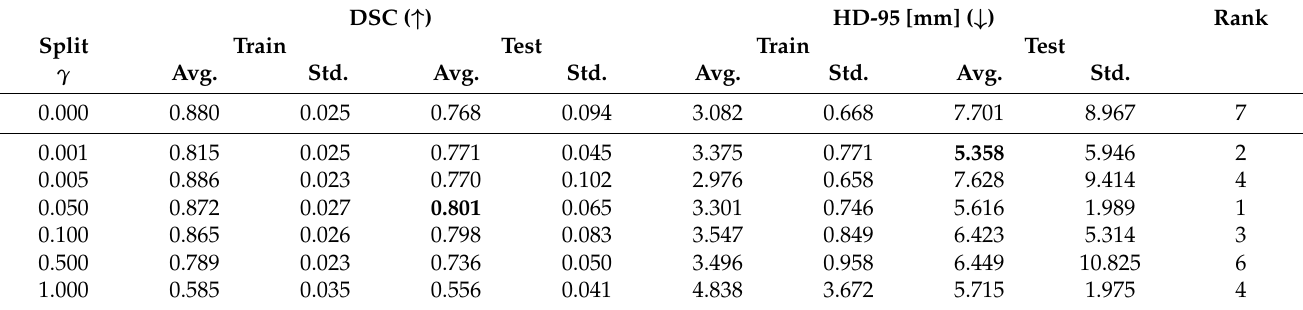
Table 4. Performance metrics for the shape distance loss weight factor γ . Displayed are the Dice coefficient (DSC) and 95th percentile Hausdorff Distance (HD-95) for which higher and lower are better, respectively. Each model is a ResNetVAE architecture trained from scratch on tagged CMR images for 200 epochs. The average (Avg.) and standard deviation (Std.) statistics are computed over the training and testing dataset splits containing 1000 and 250 2D SAX-tagged MR images, respectively. The rank is based on the cumulative ranking for both evaluation